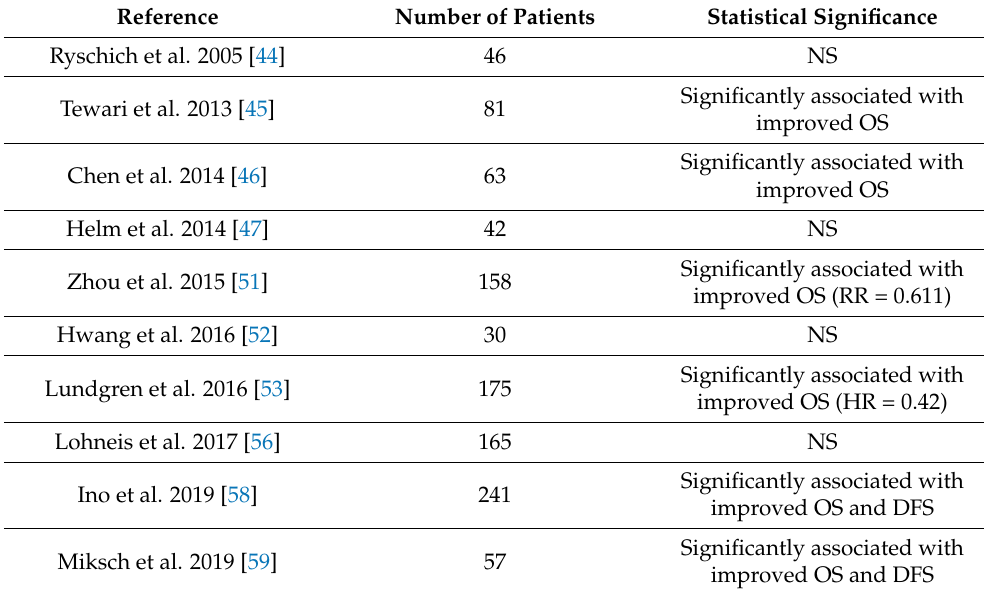
Table 1. Studies assessing CD3+ T cells expression in pancreatic ductal adenocarcinoma and the correlation with survival